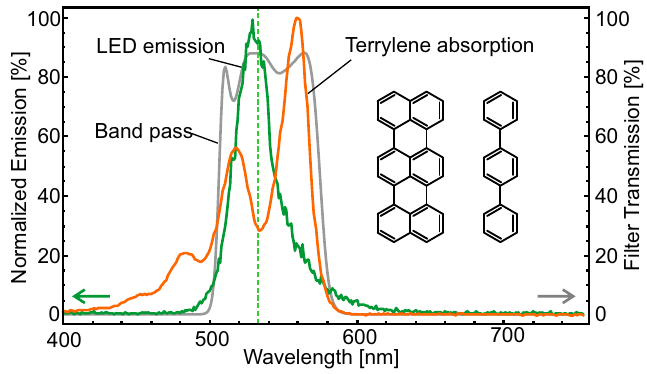
Figure 3. Absorption spectrum of terrylene and the emission spectrum of the unfiltered LED. The dashed line represents the wavelength of the frequency-doubled Nd:YAG laser. The irradiance of one to the other shows a by 40% larger value for the LED illumination. The larger spectral overlap allows a more efficient excitation. Inset: Terrylene (left) and the matrix molecule p -terphenyl